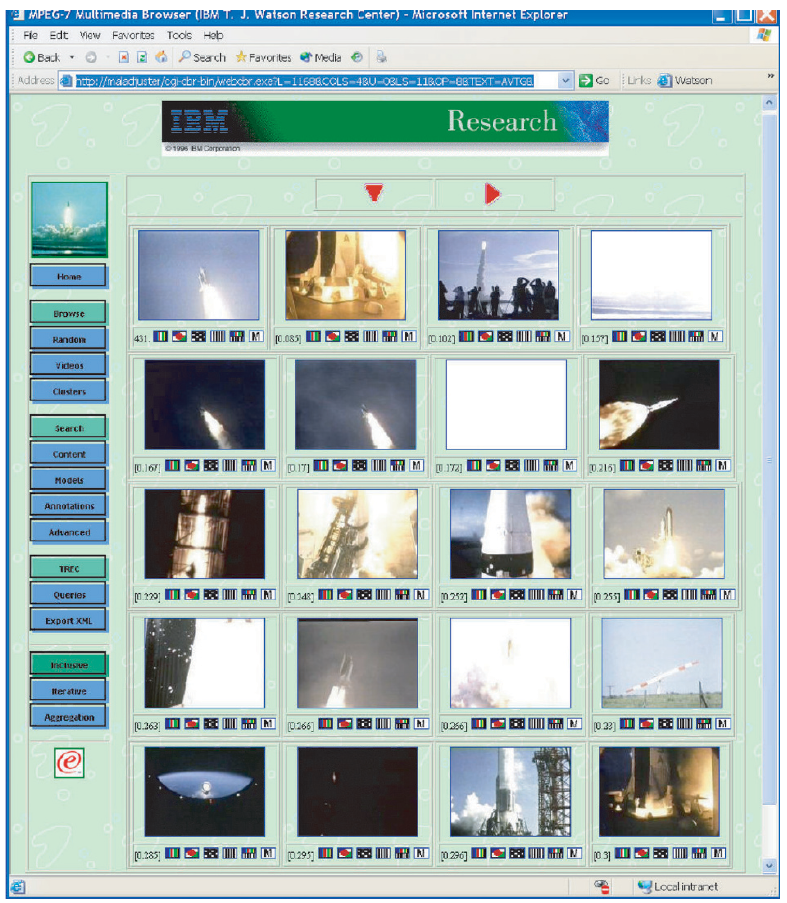
Figure 11: The top 20 video shots of rocket launch/take-o ff retrieved using multimodal detection based on the SVM model. Nineteen of the top 20 are rocket launch shots.